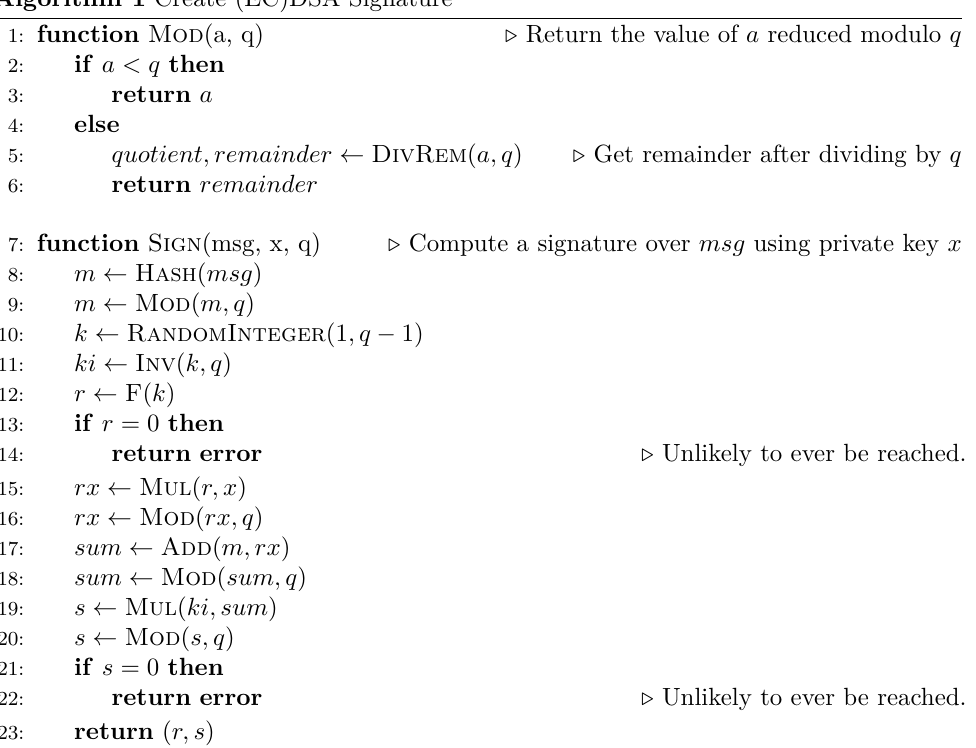
Algorithm 1 Create (EC)DSA